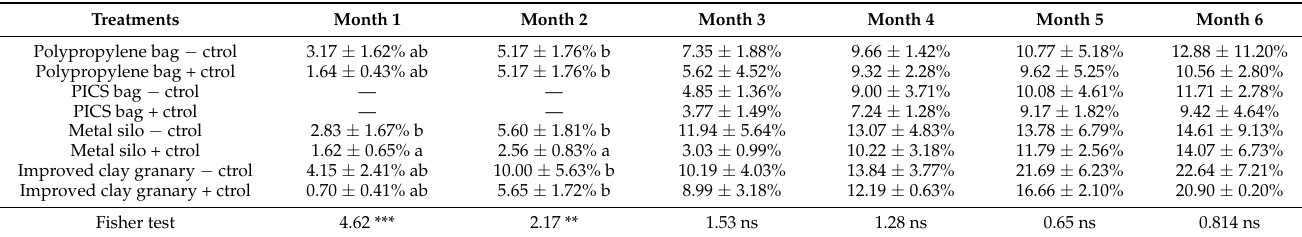
Table 1. Evolution of the average loss rates of the different treatments during storage in Savalou. Treatments